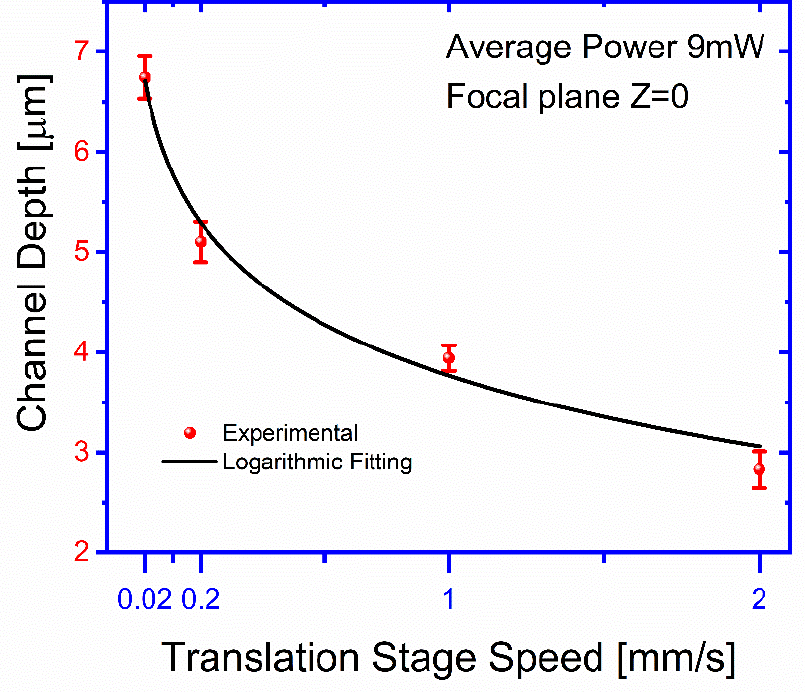
Figure 7. Channel depth as a function of different translation stage speed. The speed of the translation stages changes the depth of the channels’ range, from 2.8 ± 0.18 to 6.7 ± 0.2 µ m, and the logarithmic approximation using Equation (2) (black line).